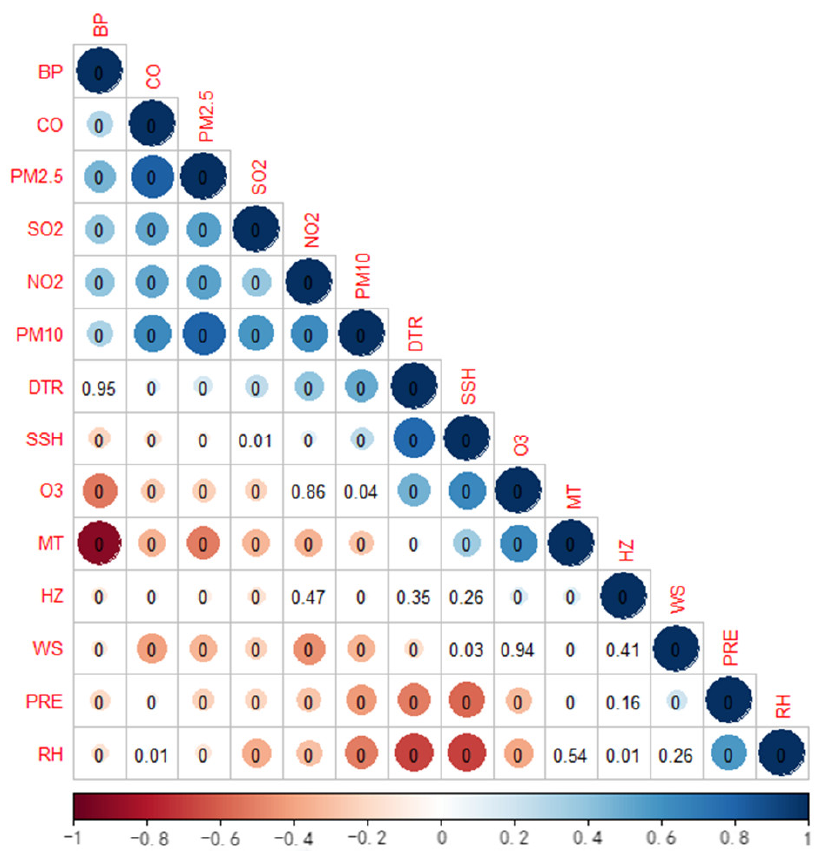
Figure 1. Spearman’s correlation coefficients between weather conditions and major pollution.